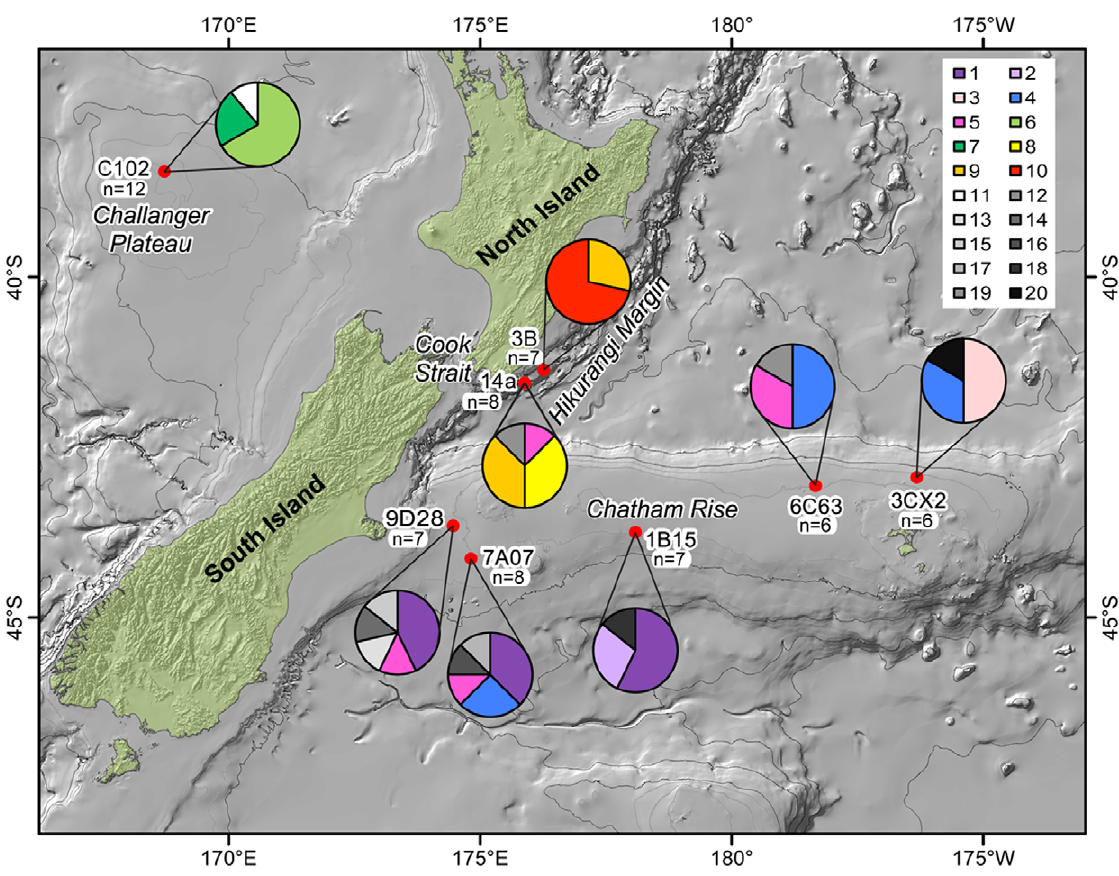
Figure 3. Distribution of COI haplotypes across the study area for Hyalinoecialongibranchiata . The location of the study sites with pie charts indicate the haplotype composition of the population from that site. Each color represents a shared haplotype. White, black, and shades of grey represent unique haplotypes. Sample sizes for each site are indicated.